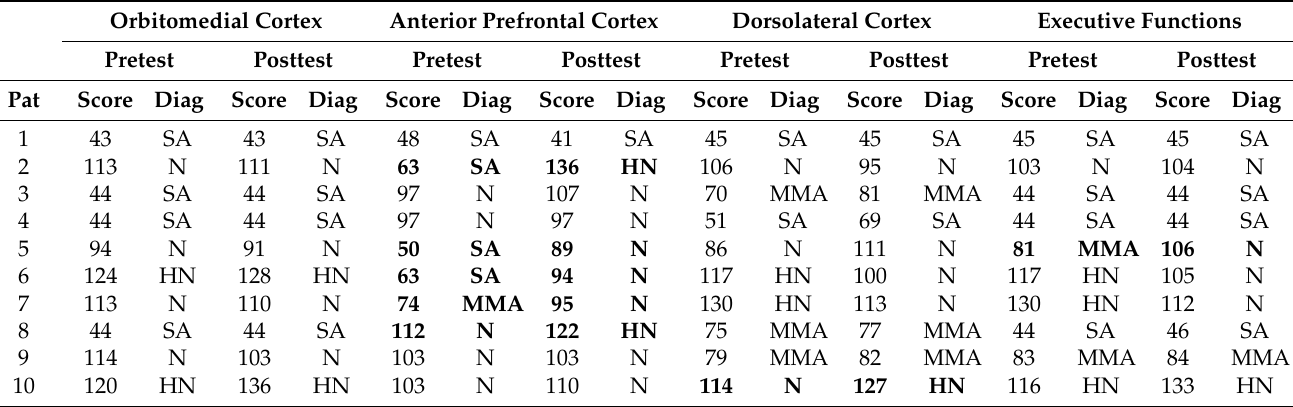
Table 4. Scores and diagnostics of neuropsychological executive functions battery in control patients with congenital heart